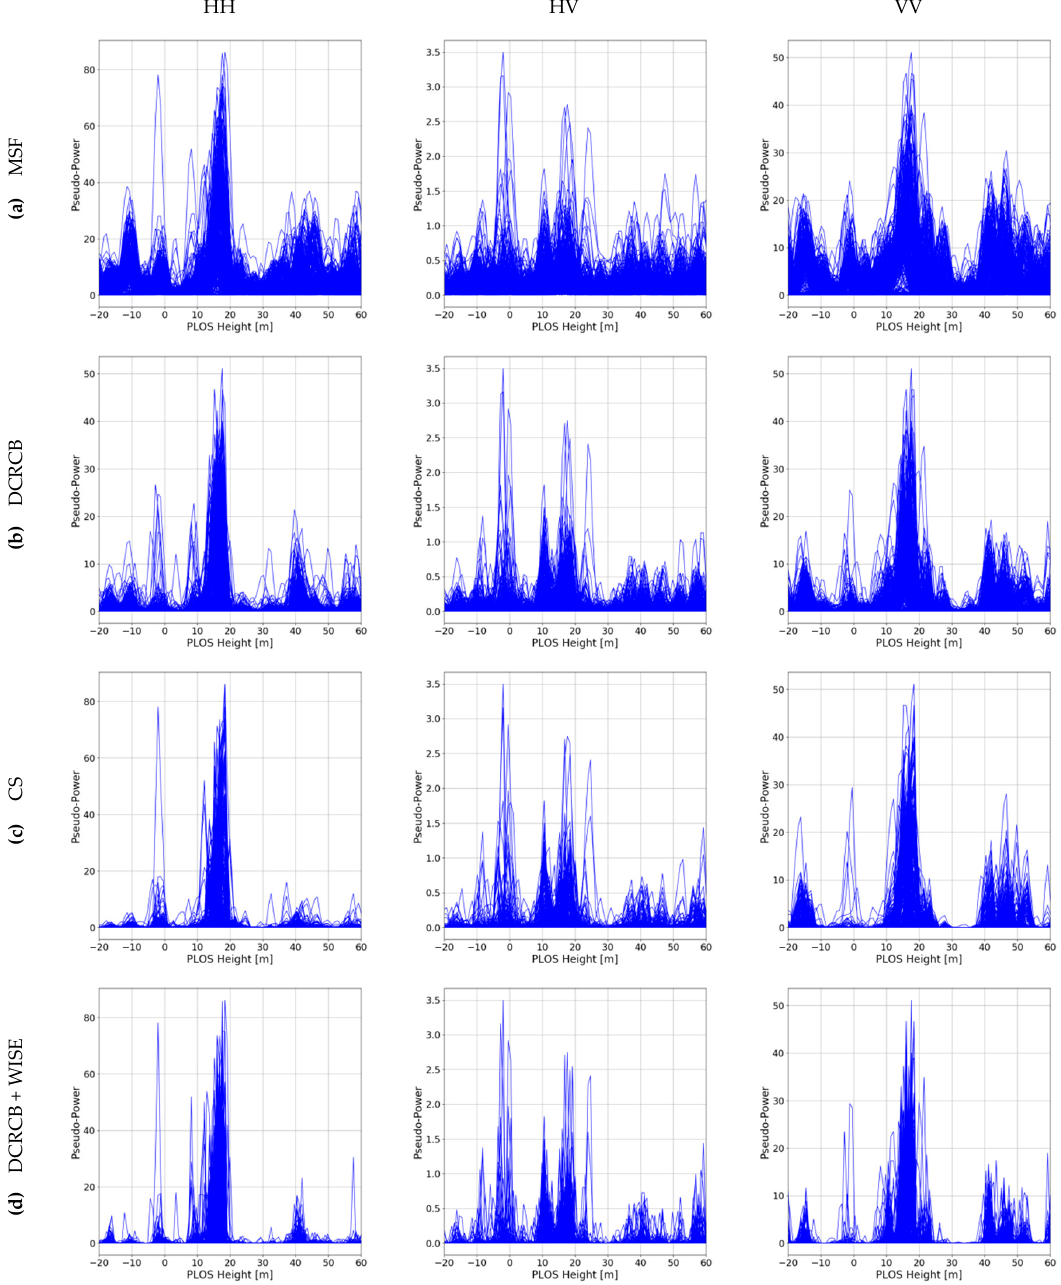
Figure 14. Two hundred and forty two superimposed vertical profiles spanning about 194 m along azimuth with a 1.2° slope, taken from the tomograms displayed in Figure 11 to Figure 13: ( a ) MSF, ( b ) DCRCB, ( c ) CS and ( d ) DCRCB + WISE. From left to right: HH, HV and VV. The (pseudo) power is presented in a linear scale.